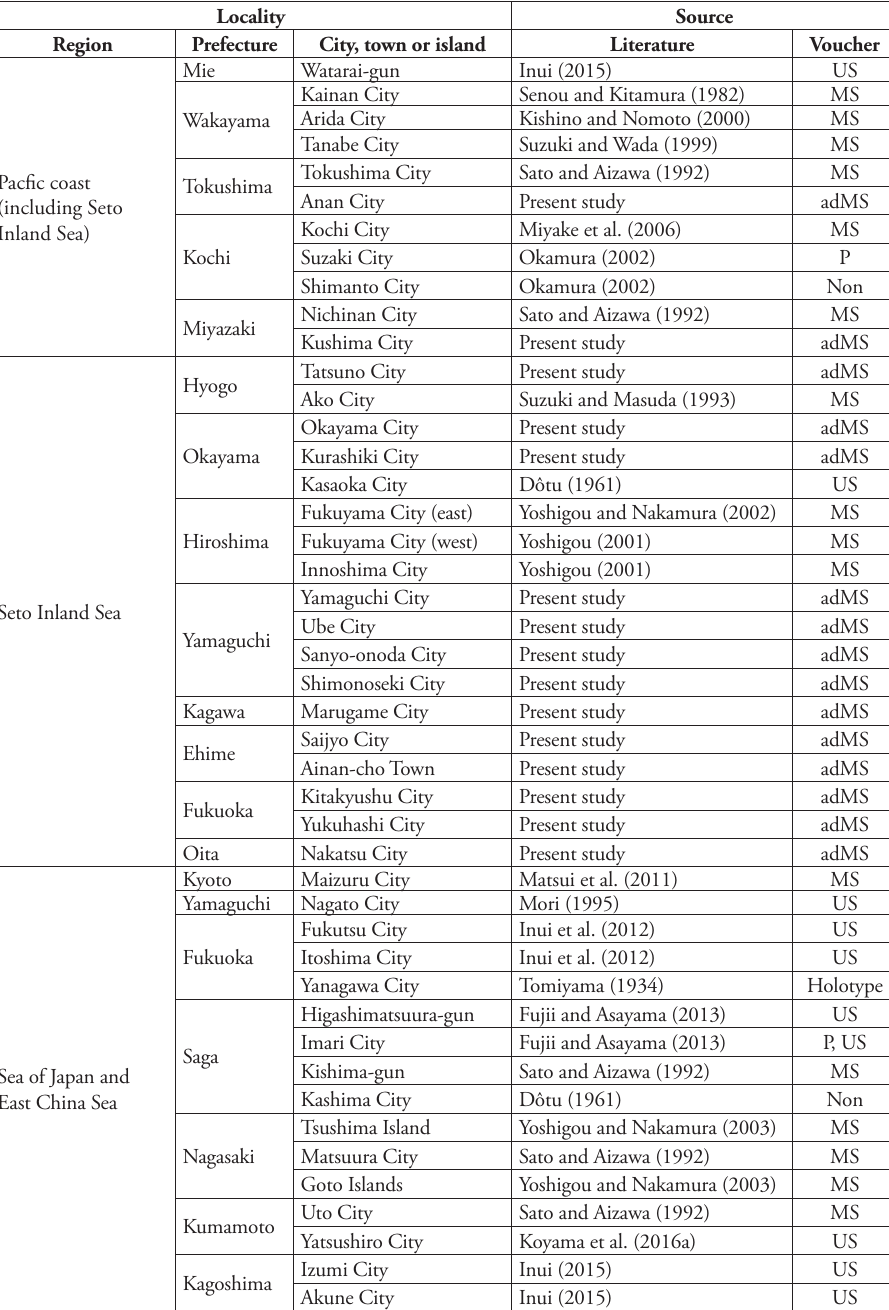
Table 2. Distribution records of Apocryptodon punctatus from Japanese waters based on literature and voucher sources.